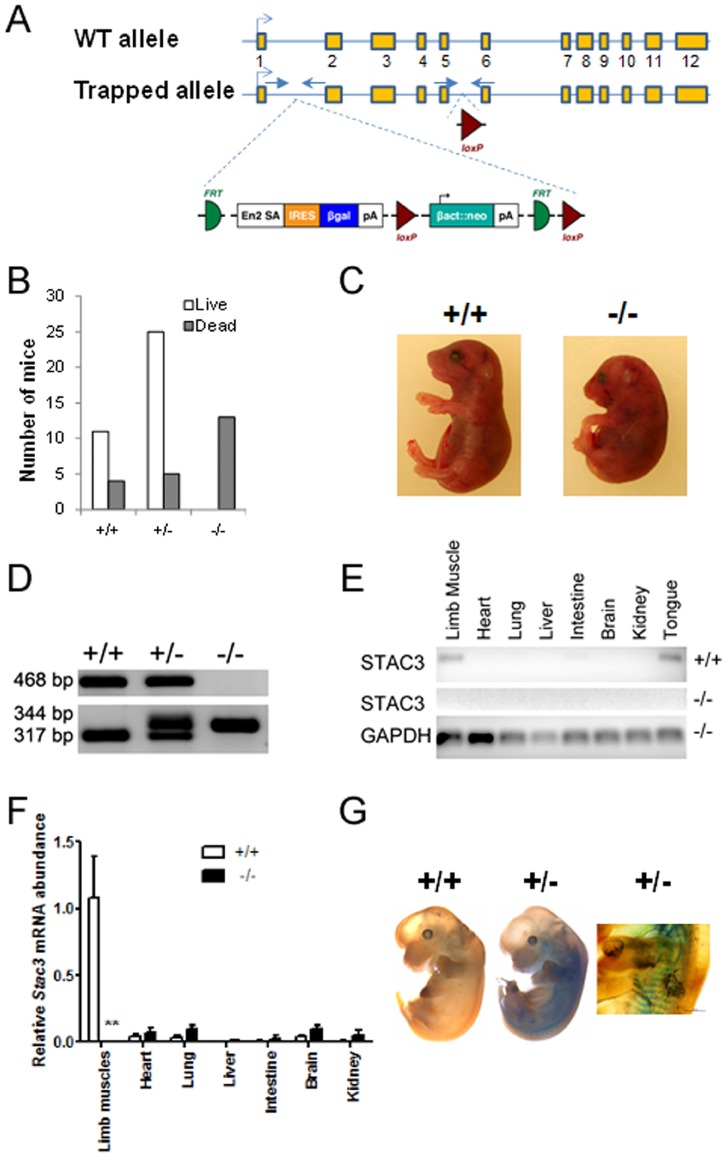
Generation and analyses of Stac3 mutant mice.
A, Schematic representation of the targeted Stac3 allele. The wild-type (WT) Stac3 allele has 12 exons, with exon 3 containing the translation start codon. The targeted allele is inserted with a trapping cassette between exons 1 and 2, and this insertion is expected to disrupt the generation of normal Stac3 mRNA. Arrows indicate locations of PCR primers for genotyping. B, Genotypes and life of newborn offspring from intercrossing mice heterozygous for the targeted Stac3 allele. “+/+”, “+/−”, and “−/−” indicate wild-type mice, and mice heterozygous and homozygous for the targeted Stac3 allele, respectively. A total of 10 litters were included in this analysis. C, Images of a Stac3 homozygous mutant mouse and a wild-type littermate. Note the curved body shape and dropping forelimbs in the mutant. D, Genotyping by PCR. See panel A for the locations of two pairs of primers. E, Validation of diminished expression of Stac3 mRNA in Stac3
−/− mice by standard RT-PCR. Shown is a representative image. F, Real-time RT-PCR validation of diminished expression of Stac3 mRNA in Stac3
−/− mice. Data are expressed as mean ± SEM (n = 4). ** P<0.01 vs. “+/+”. G, LacZ staining of E13 wild-type and Stac3
+/− embryos. Shown are representative images. The image on the right highlights the stained somites in an E13 Stac3
+/− embryo.